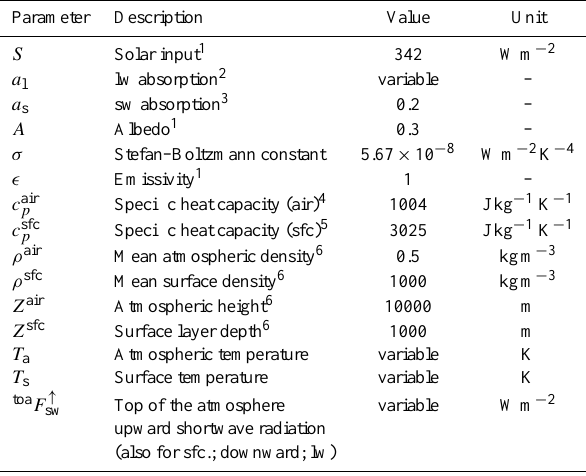
Table 2. Overview on parameters for the climate box model; lw = longwave; sw =